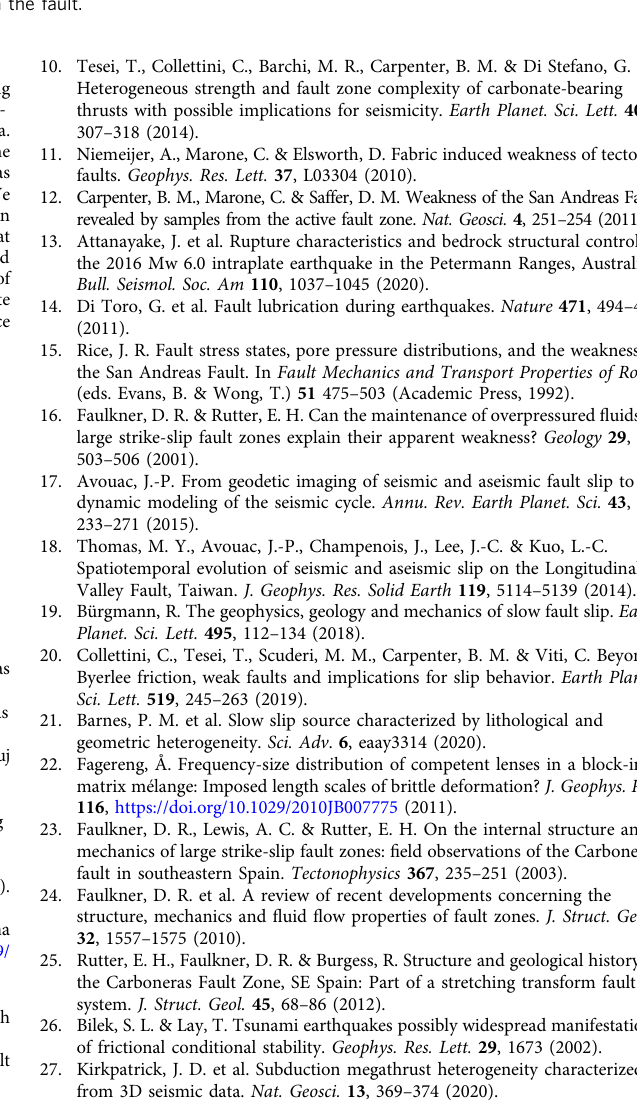
Fig. 4 Schematic fault model showing the effect of heterogeneity on fault strength and stability. For a given clay-quartz composition, the introduction of heterogeneity (i.e. the separation of clay and quartz into patches) leads to a reduction in fault strength relative to a homogeneously equivalent fault and also a decrease in stability, increasing the likelihood of seismogenesis on the